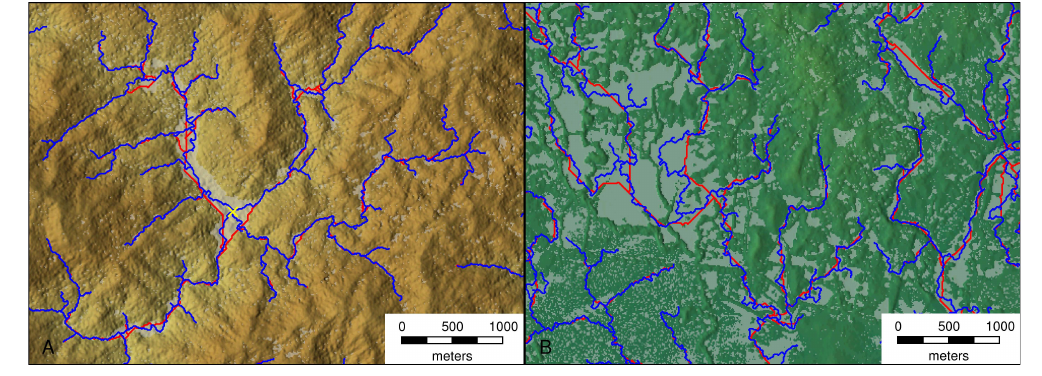
Fig. 10. Typical effects of different sink treatment methods on extracted stream courses in (A) mountainous areas and (B) costal plains. Filled sinks are grayed. Streams extracted from sink-filling in red are overlaid by streams extracted from least-cost path search in blue. Points of confluences (yellow cross) in mountainous areas can be shifted considerably, and in coastal plains, sink filling can lead to long straight lines. A shaded relief of the 10m IFSARE DEM was used as